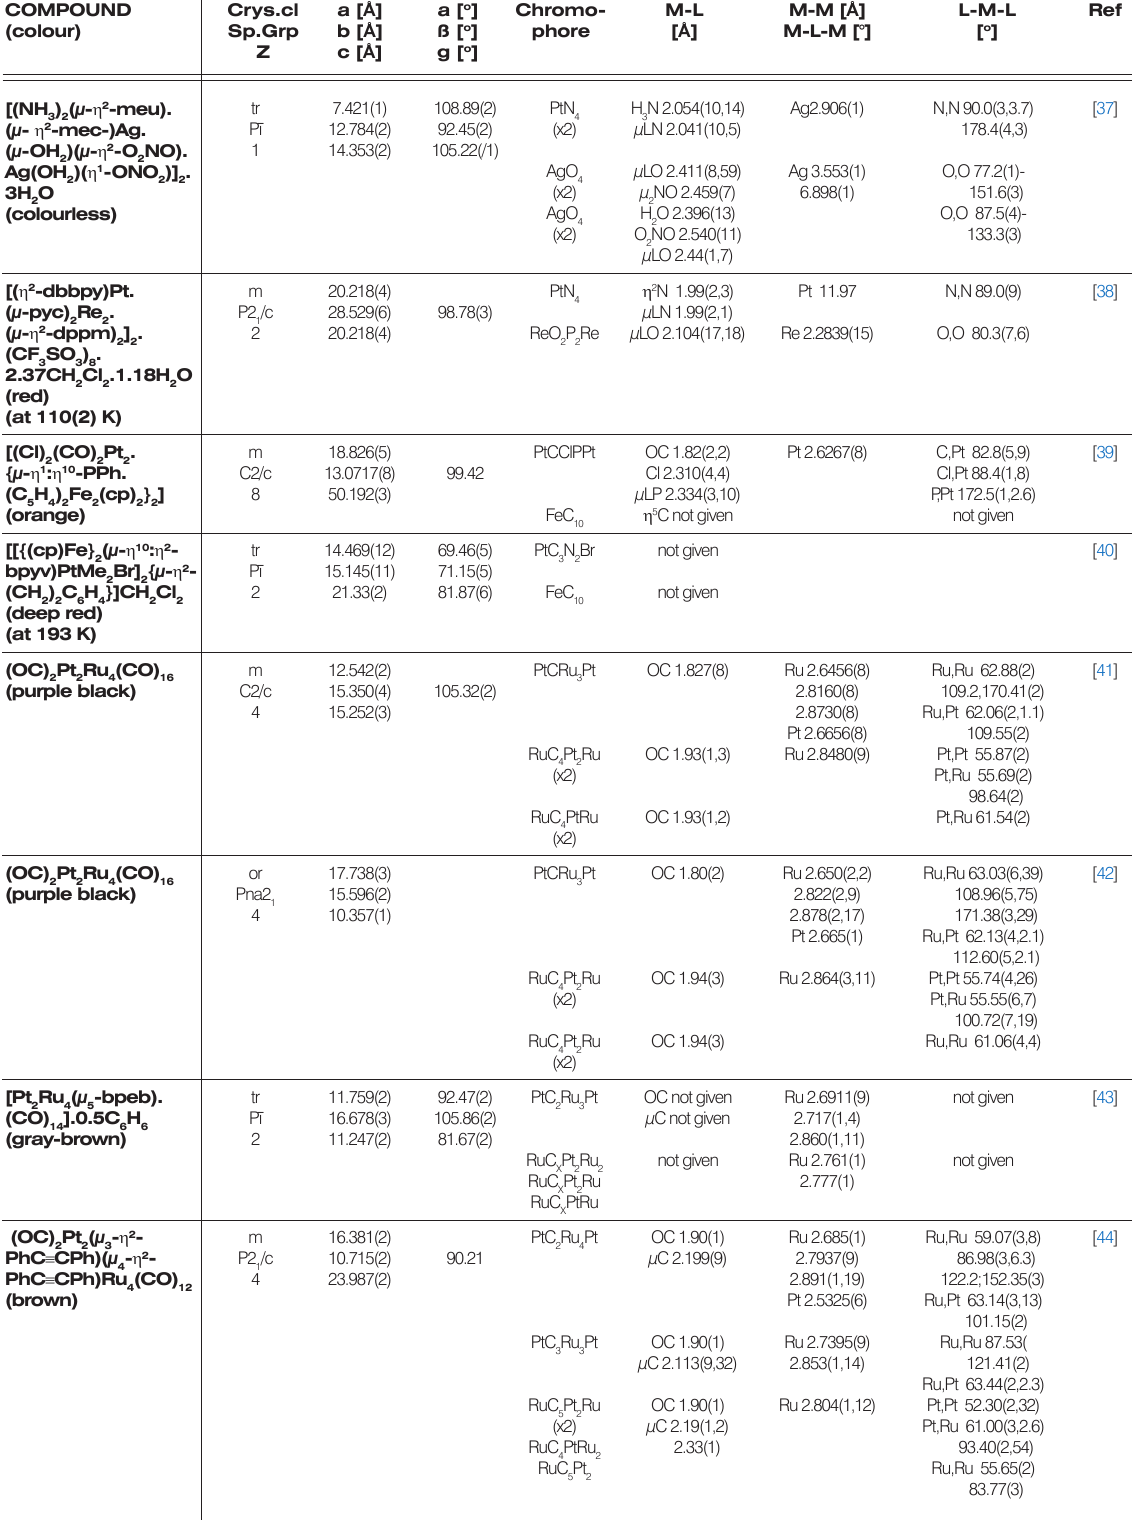
Table 2. Crystallographic and structural data for heterohexanuclear platinum clusters (Pt Continued